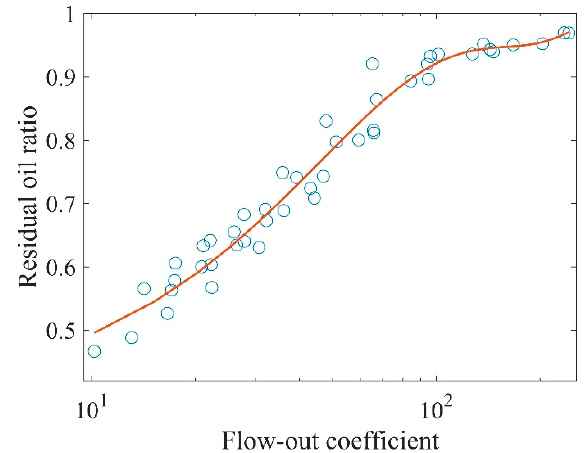
Figure 15. E ff ect of the flow-out coe ffi cient on the residual oil ratio re-calculated according to the Figure 15. Effect of the flow-out coefficient on the residual oil ratio re-calculated according to the definition in definition in [4,5].